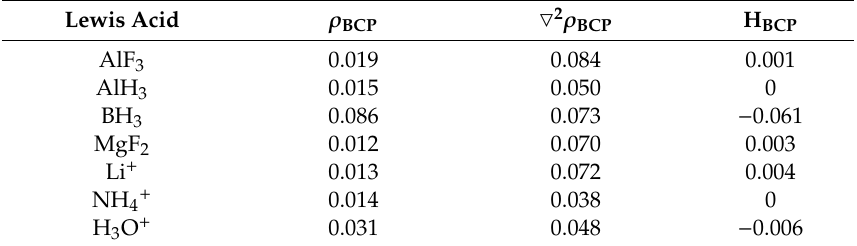
Table 4. The topological characteristics of the intermolecular bond critical point, BCP, (in au); ρ BCP —the electron density at BCP, (cid:53) 2 ρ BCP —the Laplacian of this electron density, and H BCP —the corresponding total electron energy density at BCP.